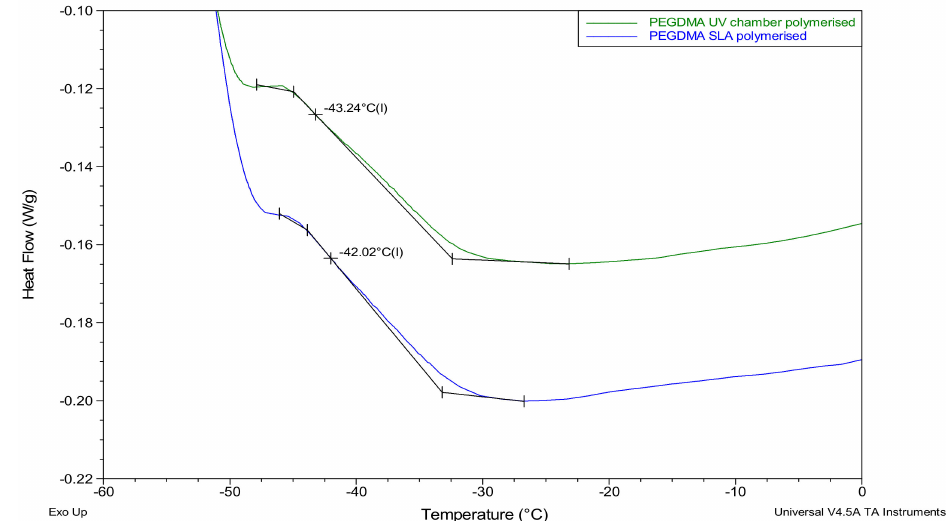
Figure 7. Di ff erential scanning calorimetry (DSC) thermograms highlighting the glass transition temperatures for the PEGDMA samples prepared via UV chamber and SLA